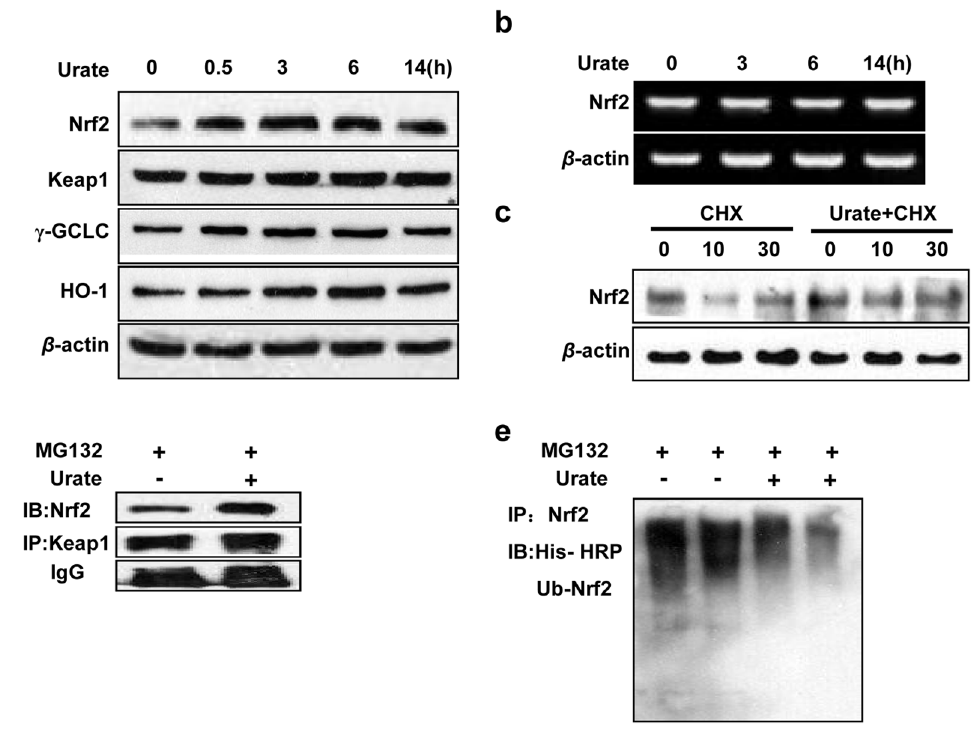
Figure 4. Effect of urate on Nrf2 activation in SH-SY5Y cells. ( a, b ) Immunoblotting and reserve transcription PCR analysis showing the protein and mRNA levels of Nrf2, Keap1, c GCLC and HO-1.Cells were treated with 200 m mol/l urate for 0.5, 3, 6 and 14 hours. b -actin served as loading controls. ( c ) Effect of urate on Nrf2 protein level in the presence of 1 m g/ml CHX. Cells were harvested and lysed at 0, 10 and 30 min after CHX addition with or without urate treatment. ( d ) Urate did not disrupt Keap1-Nrf2 complex. Cells were treated with 200 m mol/l urate for 6 h. The association of this complex was assessed using IP with anti-Keap1, followed by immunoblotting with anti-Nrf2. ( e ) Urate inhibited Nrf2 ubiquitination. Cells were treated with or without urate for 6 h in the presence of MG132 (25 m M). For detecting ubiquitinated Nrf2, samples were subjected to IP with anti-Nrf2, followed by IB with an anti-His-HRP-conjugated antibody. The results were independently repeated at least three times.